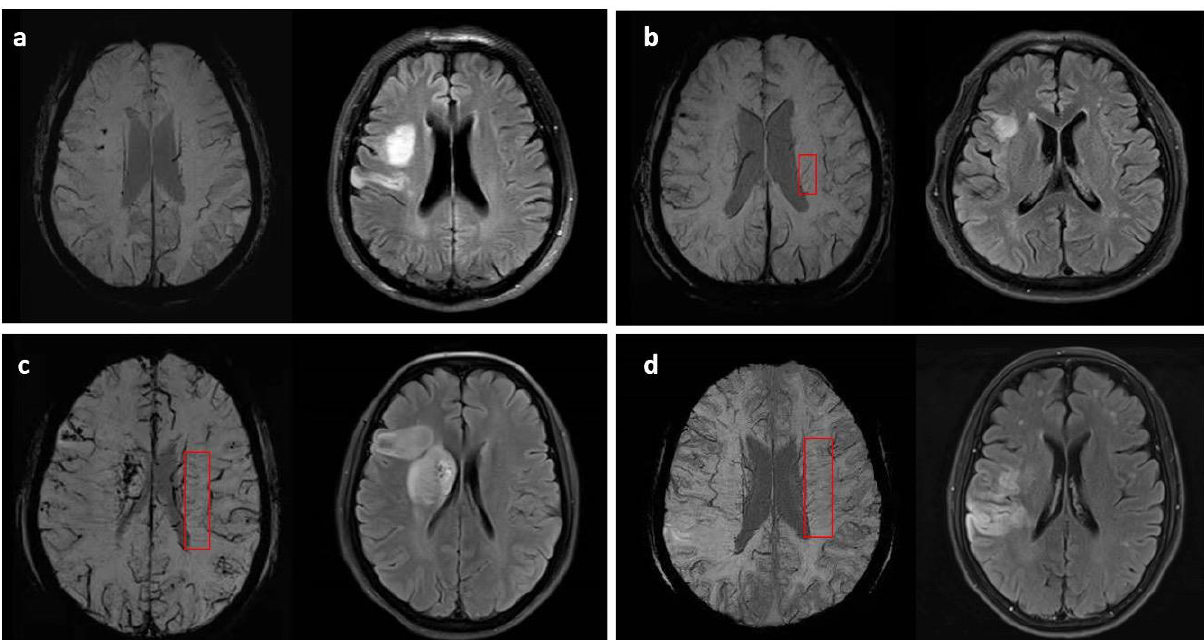
Figure 1. Examples and demonstrations of the four-grade DMVs (marked in the red box) scoring method on SWI with corresponding infarction lesions: ( a ) grade 0, no visible conspicuous and continuous DMVs; ( b ) grade 1, <5 conspicuous DMVs; ( c ) grade 2, 5–10 conspicuous DMVs; ( d ) grade 3, >10 conspicuous